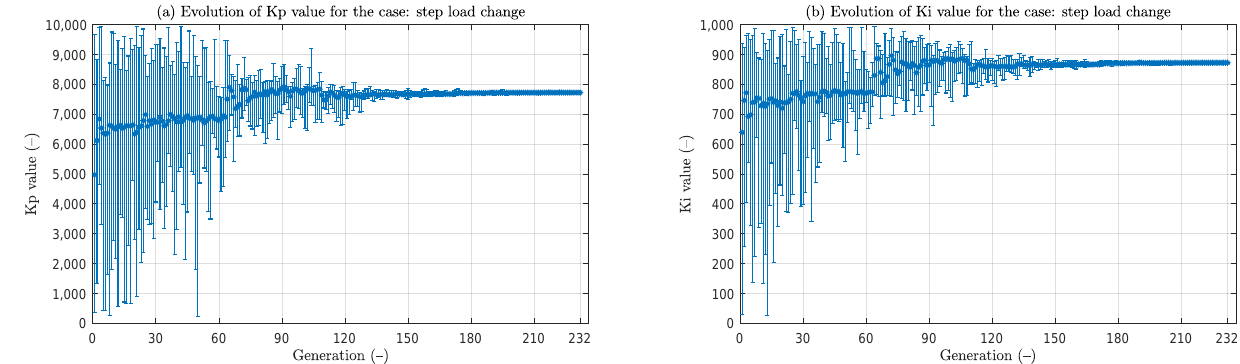
Figure 13. Evolution of parameters for the case of step load change: ( a ) Kp; ( b )